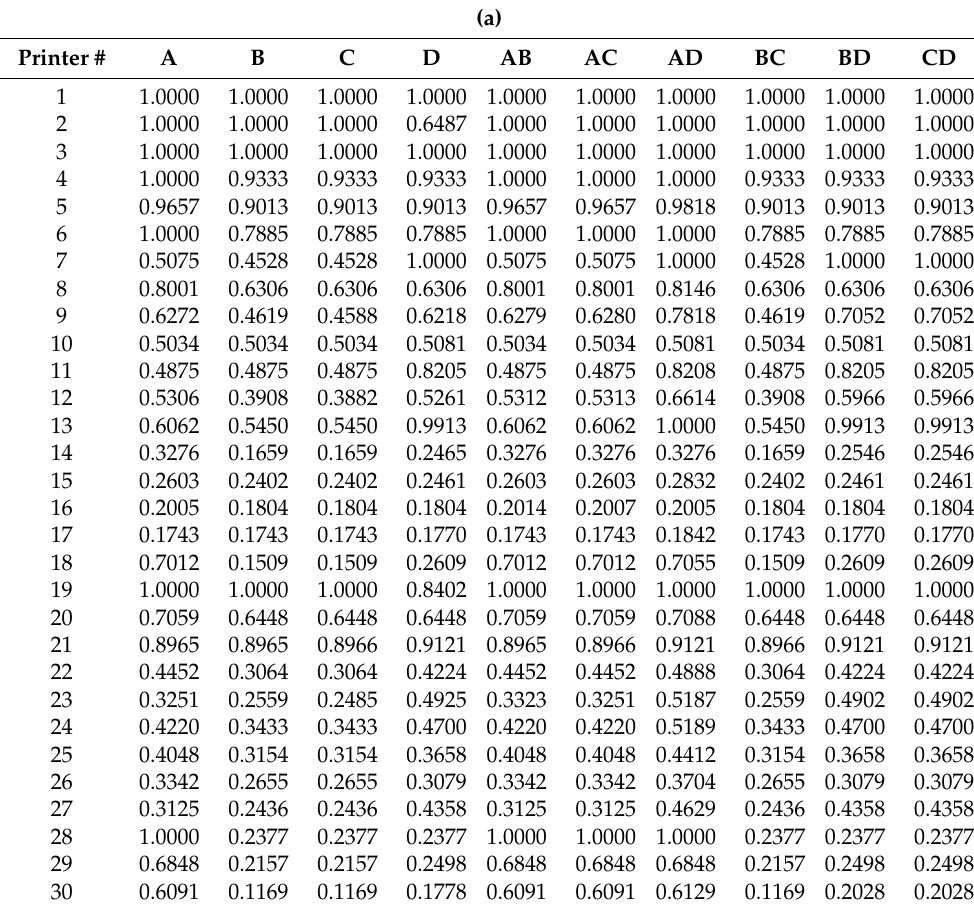
Table 6. Evaluated efficiency of 3D printers, according to the CCR ( a ) and the BCC ( b ) model, for the output combinations of Table 5.